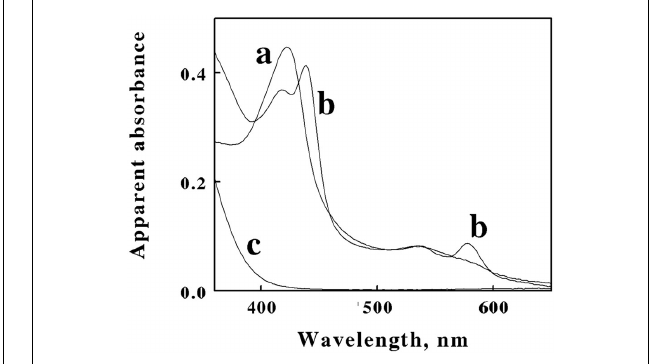
FIGURE 3 |Apparent absorbance spectra of intact L. ferrooxidans collected in the CLARiTY in the absence ( a ) and presence ( b ) of 100mM ferrous sulfate in aerobic sulfuric acid, pH 1.7. The final bacterial suspension contained 2.1 × 10 9 cells of L. ferrooxidans in 4.2ml. Curve c shows the apparent absorbance spectrum of 50 μ M ferric ions under the same solution conditions in the absence of